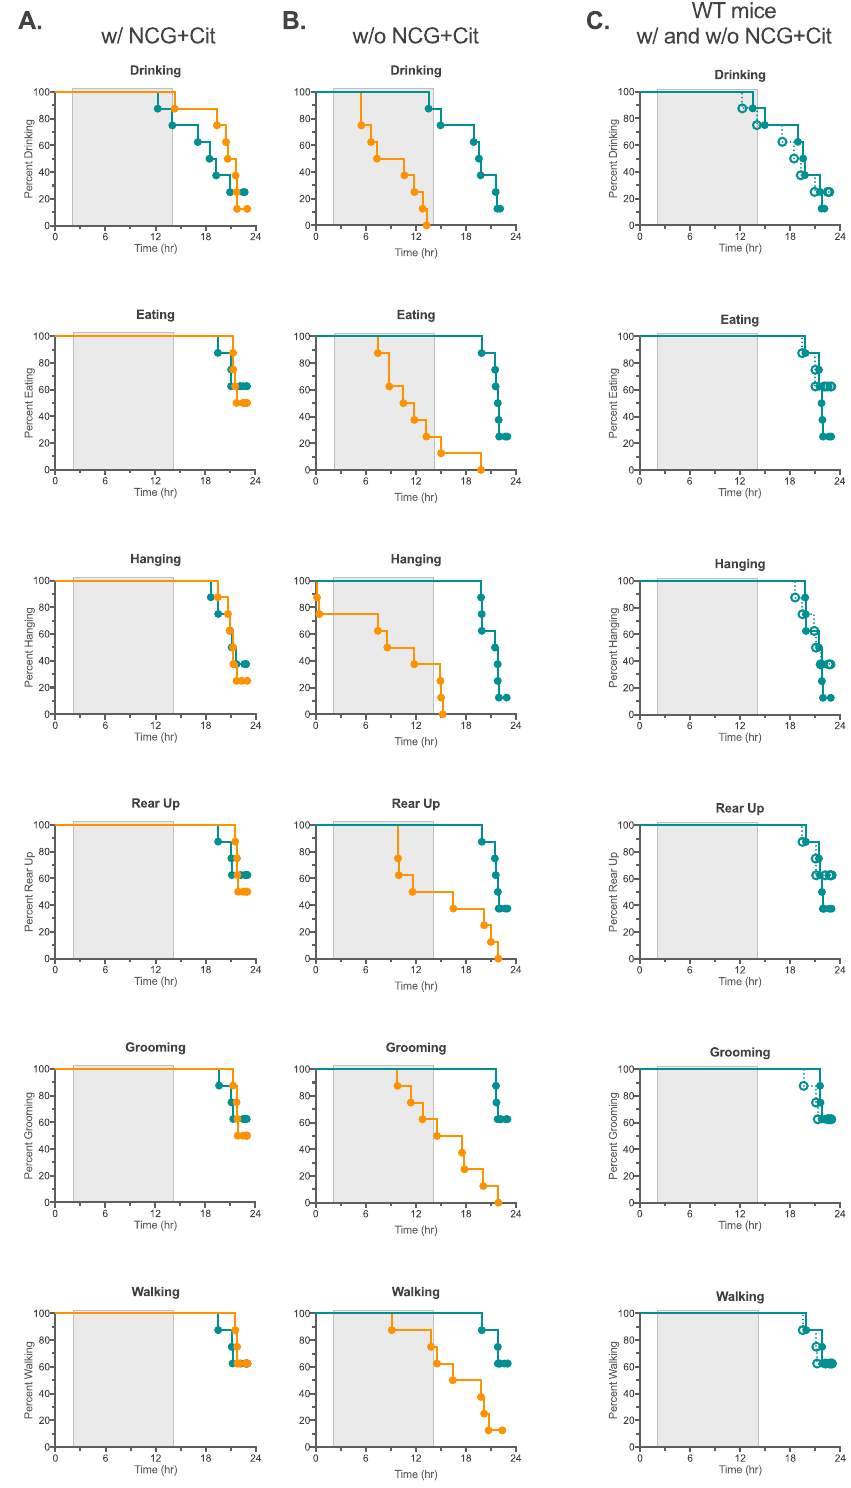
Figure 1. Differing behaviors of Nags −/− (orange) and Nags + / + (teal) mice with respect to cessation of drinking, eating, hanging, rearing up, grooming, and walking ( A ) during the 24 h before withdrawal of NCG + Cit supplementation and ( B ) in the 24 h period after withdrawal of NCG + Cit supplementation at 4 PM. The same results are shown in ( C ) for wild-type mice before (solid) and after (hatched) withdrawal of NCG + Cit supplementation. Shaded rectangles indicate the period of darkness between 6 PM and 6